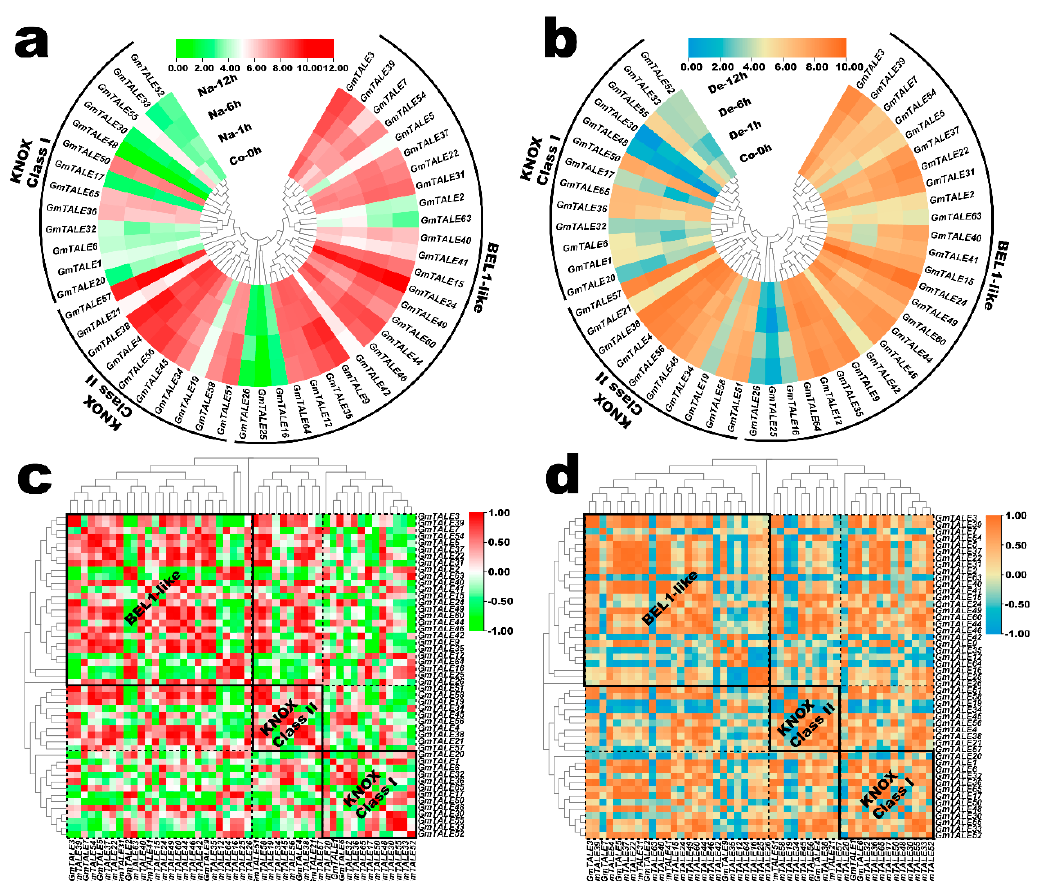
Figure 8. Expression profiling of GmTALE genes in the soybean root during saline stress and dehydration. ( a ) Hierarchically clustered expression profiles of GmTALE genes in the soybean root during saline stress. Na: saline stress; Co: control. ( b ) Hierarchically clustered expression profiles of GmTALE genes in the soybean root during dehydration. De: dehydration. ( c ) Gene expression correlation heatmap of the expressed GmTALE genes in the soybean root during saline stress. Red: positively correlated; green: negatively correlated. ( d ) Gene expression correlation heatmap of the expressed GmTALE genes in the soybean root during dehydration. Orange: positively correlated; blue: negatively correlated. The phylogenetic tree was as built used the maximum likelihood (ML) method with the best scoring JTT + G + I model.